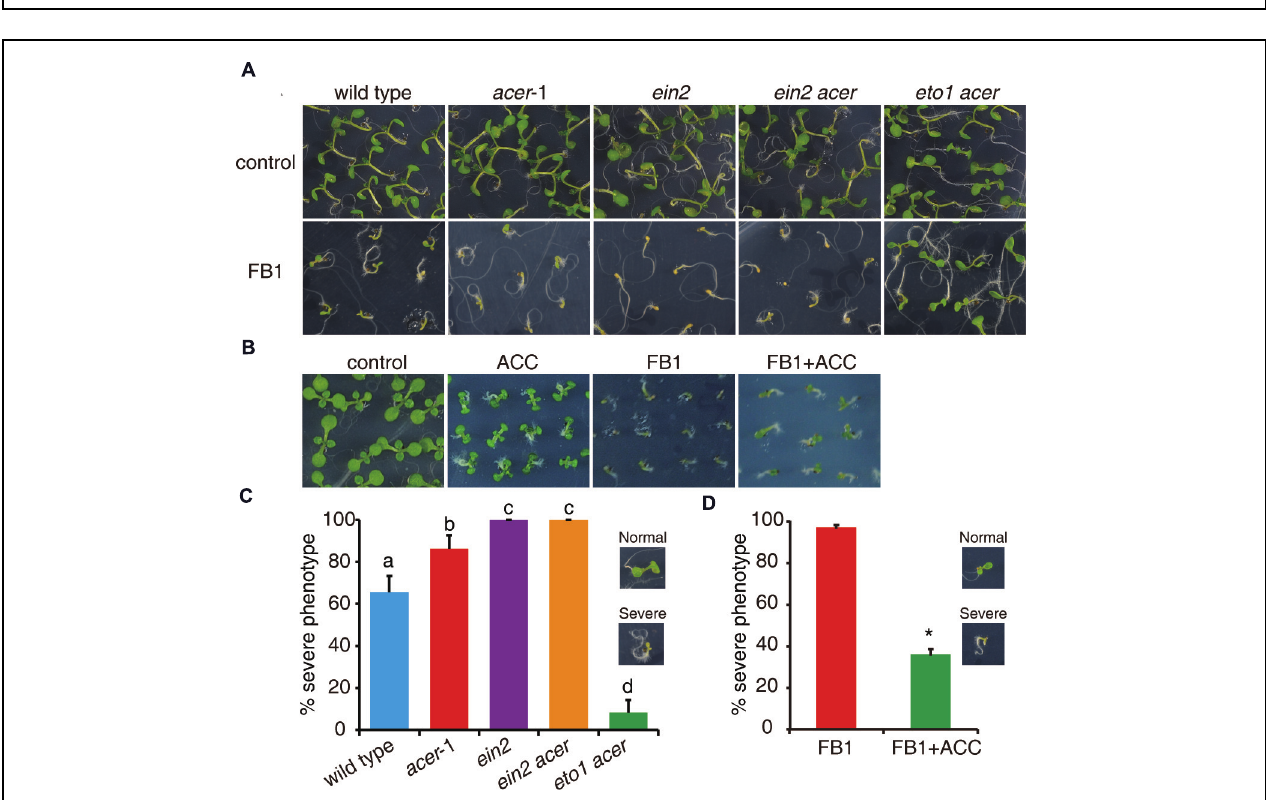
FIGURE 4 | Phenotypes of FB1-treated wild-type, acer-1, ein2, ein2 acer , and eto1 acer plants. (A) Seeds were germinated on 1/2x MS with or without 0.5 µ M FB1. Photos were taken after 8 days of treatment. (B) ACC reduces FB1-induced cell death in acer -1 mutant. Seeds were germinated on 1/2x MS supplemented with various combinations of 0.5 µ M FB1 and 50 µ M ACC. Photos were taken after 2 weeks of treatment. (C) Quantitative analysis of the phenotype of seedlings in (A) . Data presented are means ± SD ( n = 3) and sets marked with different letters indicate significances assessed by Student–Newman–Keul test ( P < 0.05). (D) Quantitative analysis of the phenotype of seedlings in (B) . Data presented are means ± SD ( n = 3) and asterisk indicates P < 0.01 using Student’s t